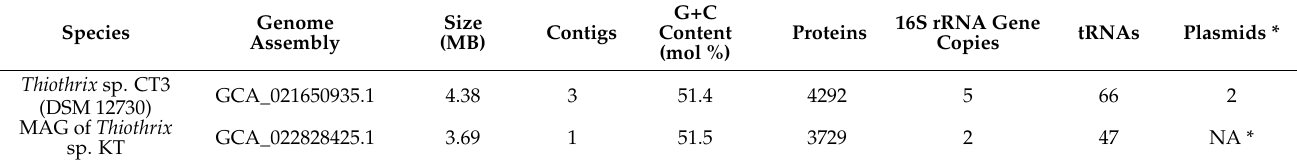
Table 2. The general properties of assembled Thiothrix genomes.